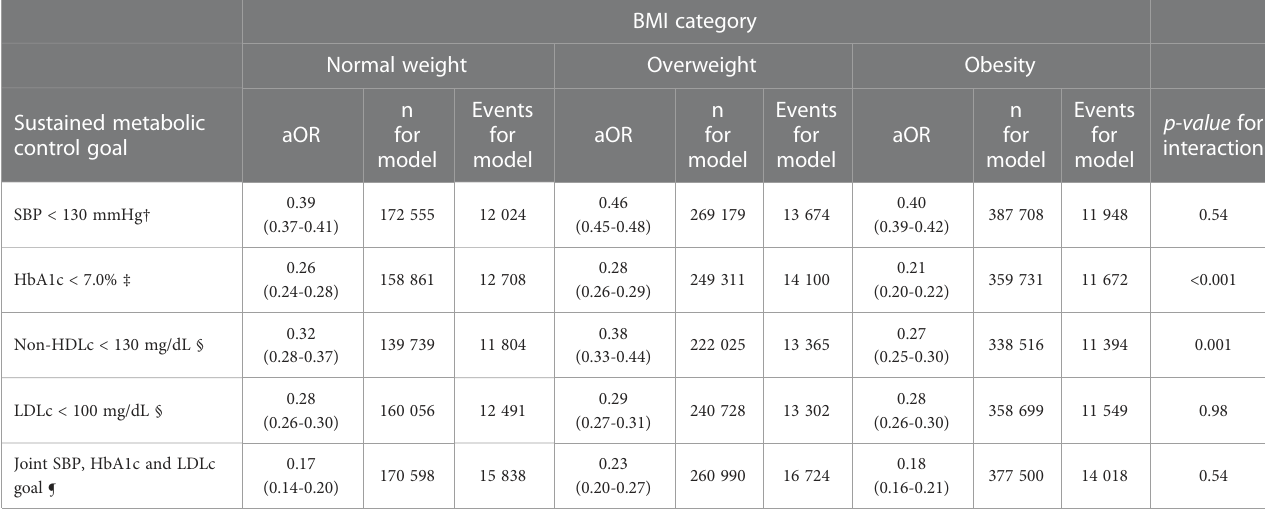
TABLE 3 Association between sustained metabolic control and mortality, by body-mass index